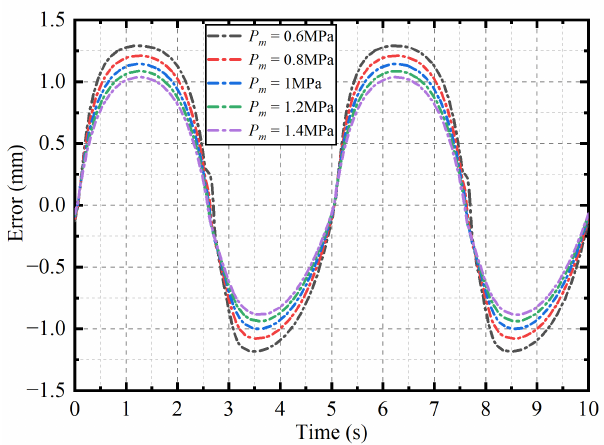
Figure 25. Tracking error at different safety margin pressure P m .